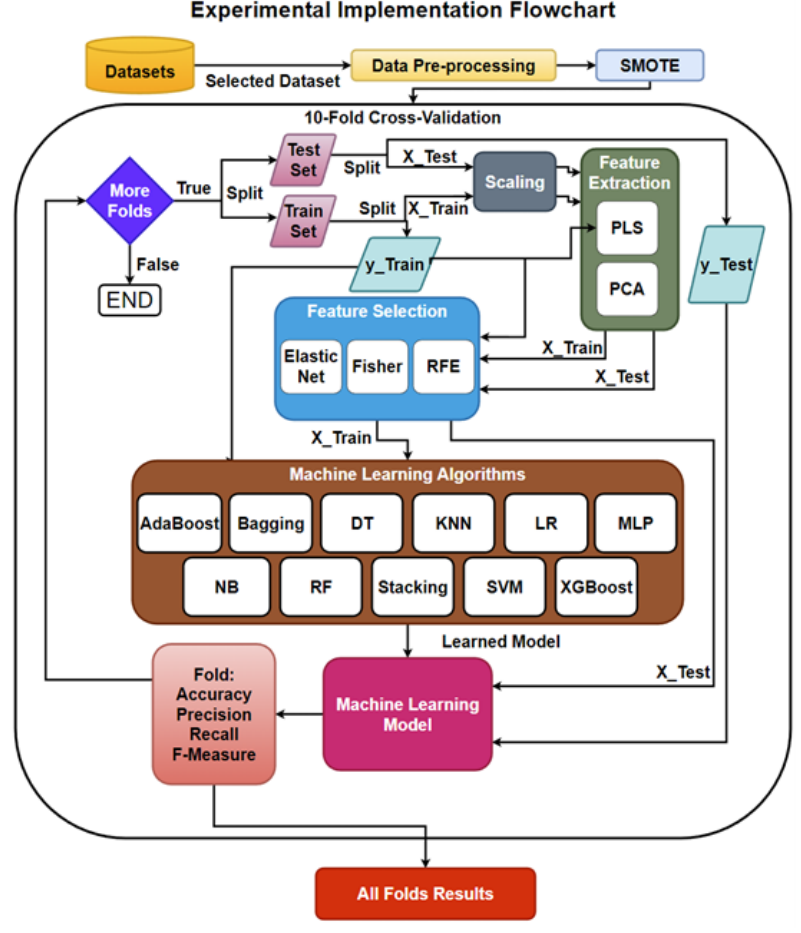
Figure 11. The Experimental Setup for the Model Building